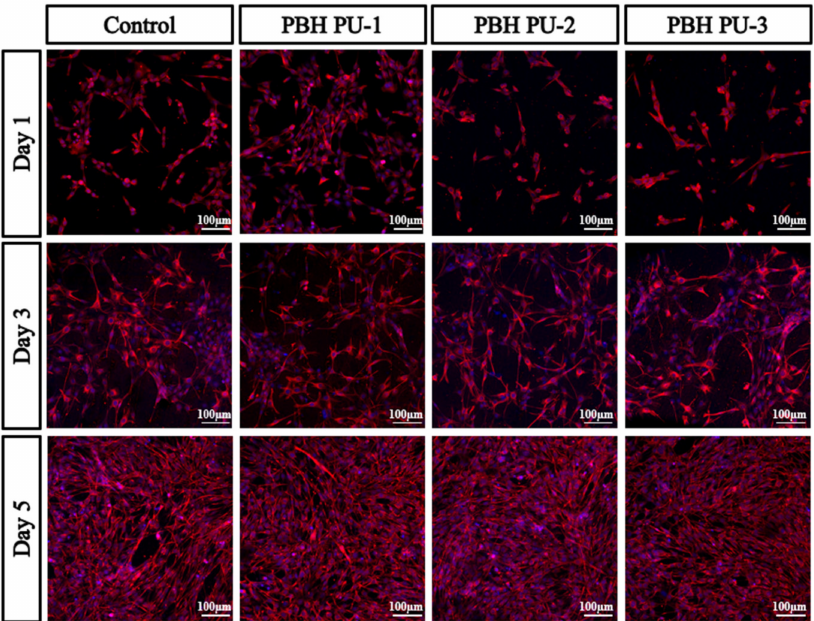
Figure 11. Confocal image of immunocytochemistry staining with F-actin (red) and nuclei (blue) of the adherent cells on the PCD films at 1, 3, and 5